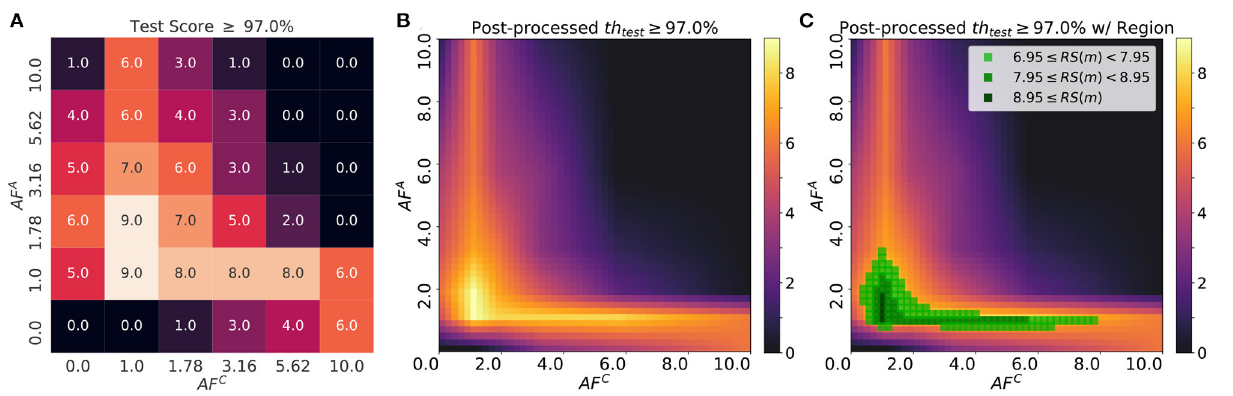
FIGURE 8 | (A) The robustness score based on the test accuracy with a given threshold, 97.0%, where the number indicates how many cases with the test accuracy over the threshold. dw min is set at 0.001. (B) The post-processed robustness score, where the step size of each domain in AF is 0.2 and σ = 0.2. (C) The regions with high robustness score are highlighted to visualize the area where the test accuracy is universally high as the learning rates